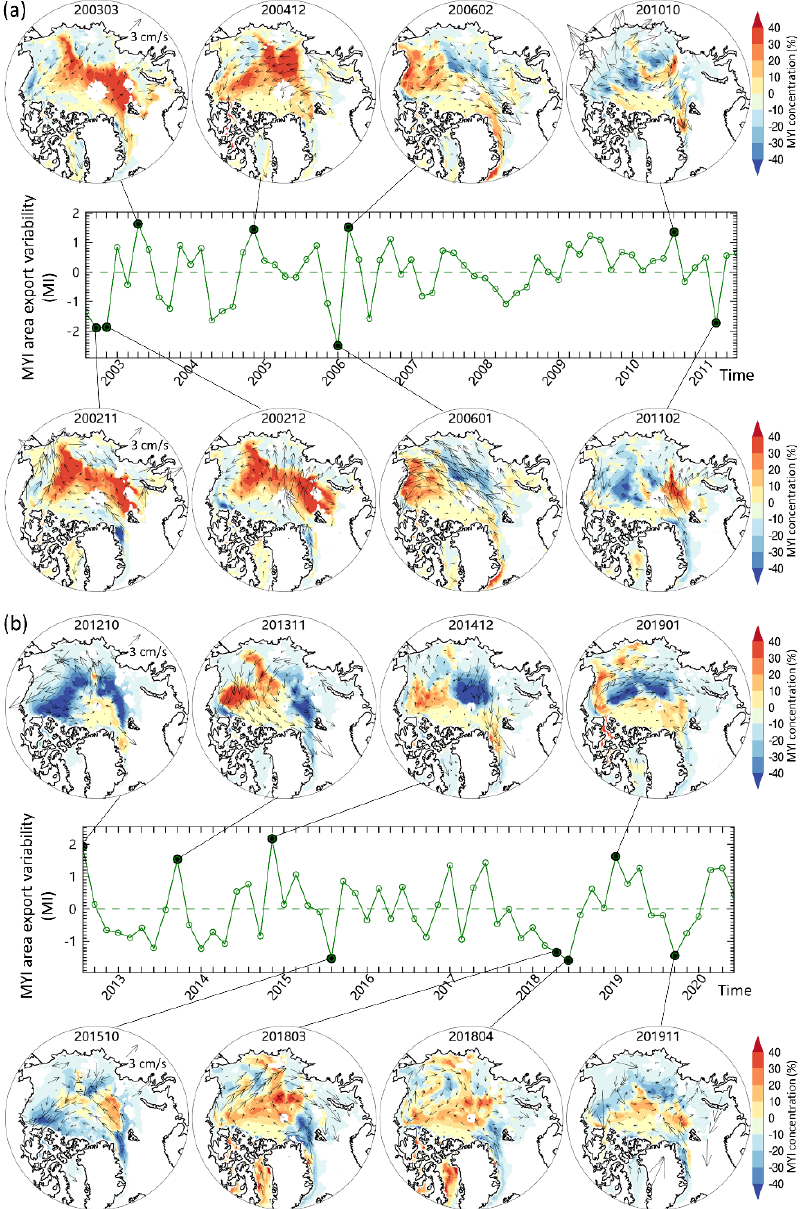
Figure 4. Monthly variability in the MYI area export anomaly through the FS in winter and spatial patterns of Arctic MYI concentration and sea ice drift corresponding to most four positive/negative events of MYI exports. ( a ) Top/bottom graphs superimposed by MYI concentration and sea ice drift show the four most positive (MI > 1.4) and negative (MI < −1 .8) events for period D1. ( b ) Top/bottom graphs show four most positive (MI > 1.6) and negative (MI < − 1.4) events in period D2. MI is normalized MYI export index and calculated by Equation